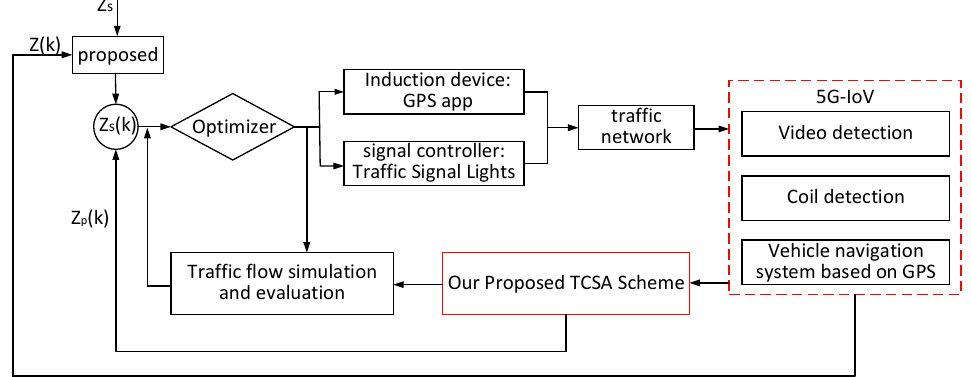
Figure 15. Structure diagram of the improved traffic guidance control system based on the TCSA scheme.